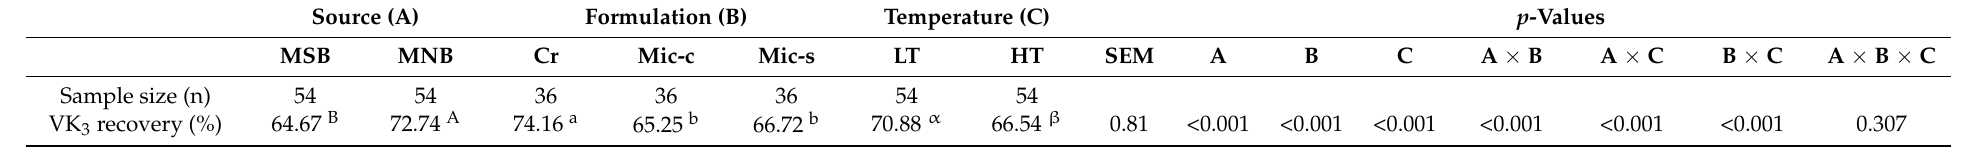
Table 1. Effects of sources and formulations of vitamin K 3 and extrusion temperature on its stability.